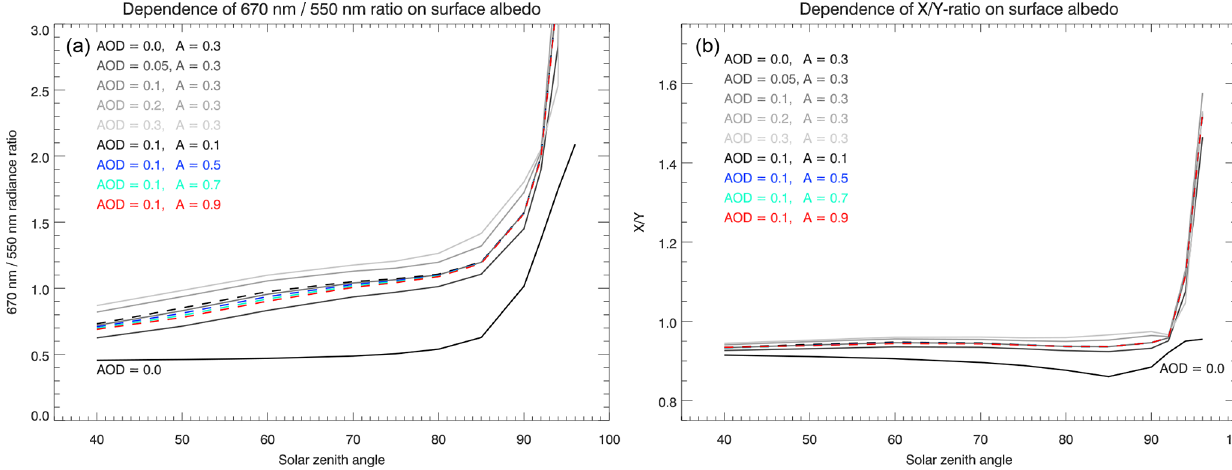
Figure 6. Ratio of the scattered solar radiances at 670 and 550nm (a) and the X/Y tristimulus value ratio (b) as a function of SZA and for different values of the stratospheric AOD and different surface albedos. Other relevant parameters: VZA = 85 ◦ , SAA = 10 ◦ , TOC = 300DU, r med = 250nm, S = 1 .